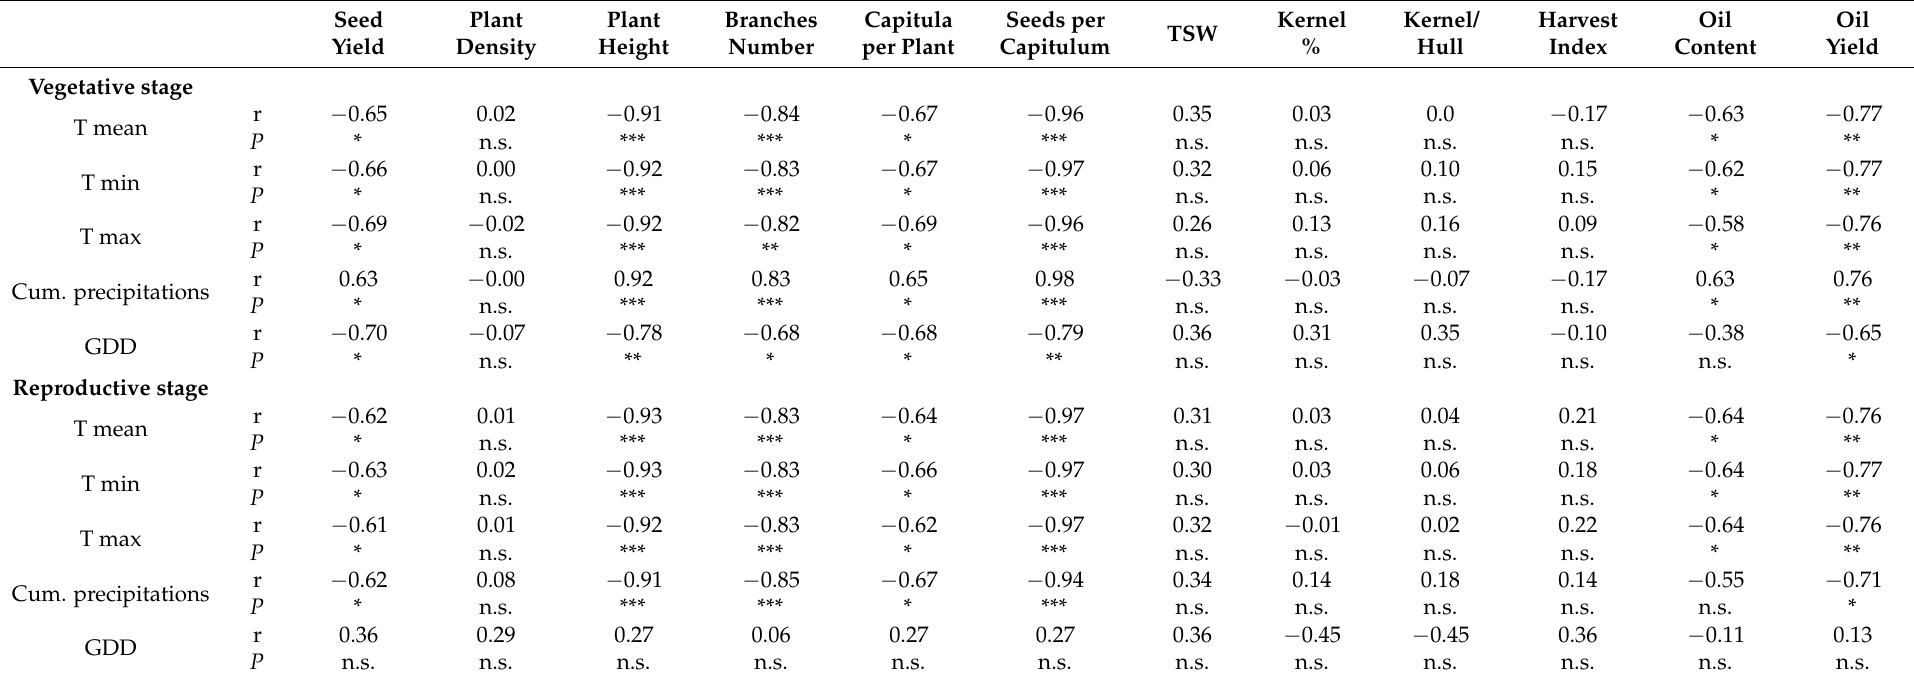
Table 9. Pearson’s correlation coefficients (r) and their statistical significance ( P ) among yield and yield characteristics and climate variables in the vegetative and reproductive stage of six safflower genotypes grown across two years (2012–2013). ***, significant at p ≤ 0.001 level; ** significant at p ≤ 0.01; *, significant at p ≤ 0.05 level; n.s., not